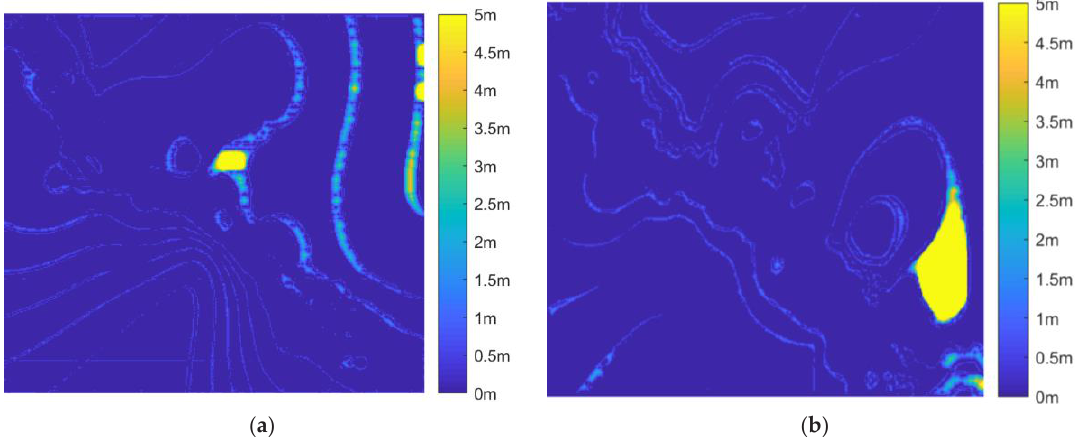
Figure 12. Di ff erence plot between the ground truth depth map and the predicted depth map for Figure 12. Difference plot between the ground truth depth map and the predicted depth map for Nantong ( a ) and Fangcheng ( b ) ports. Nantong ( a ) and Fangcheng ( b ) ports. Table 3. Results of depth classification: mean square error (MSE) and coe ffi cient of determination ( R 2